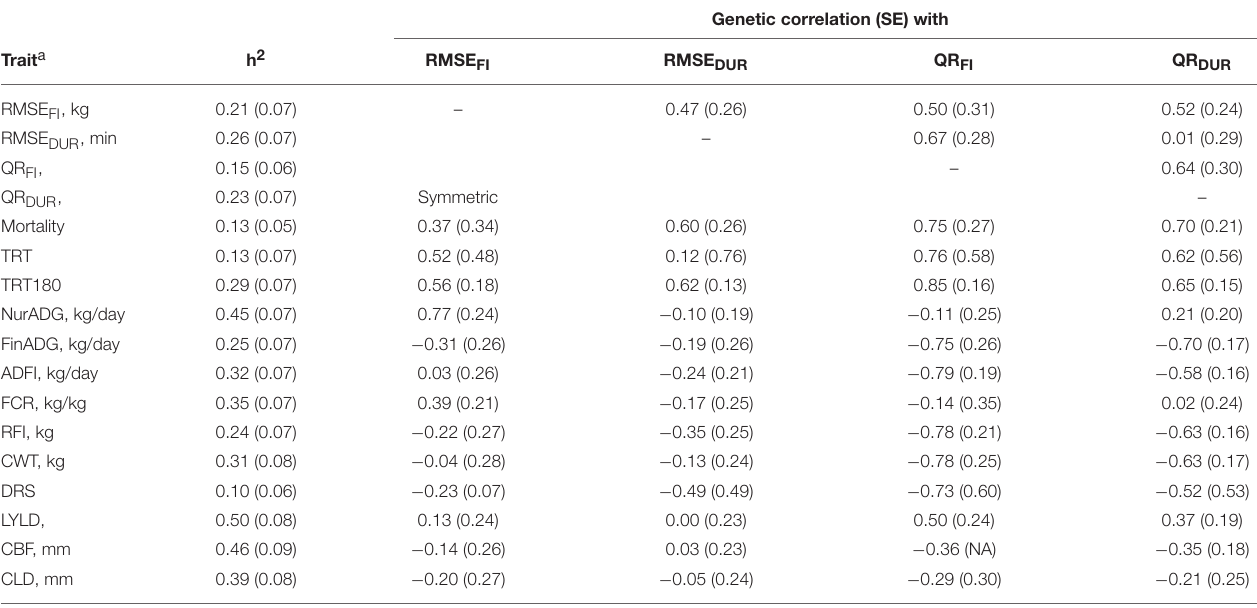
TABLE 3 | Estimates of heritability (SE) for traits analyzed and of genetic correlations (SE) with resilience measures ( n = 1341 total animals, see Table 2 for actual counts per phenotype). Genetic correlation (SE) with Trait a h 2 RMSE FI RMSE DUR QR FI QR